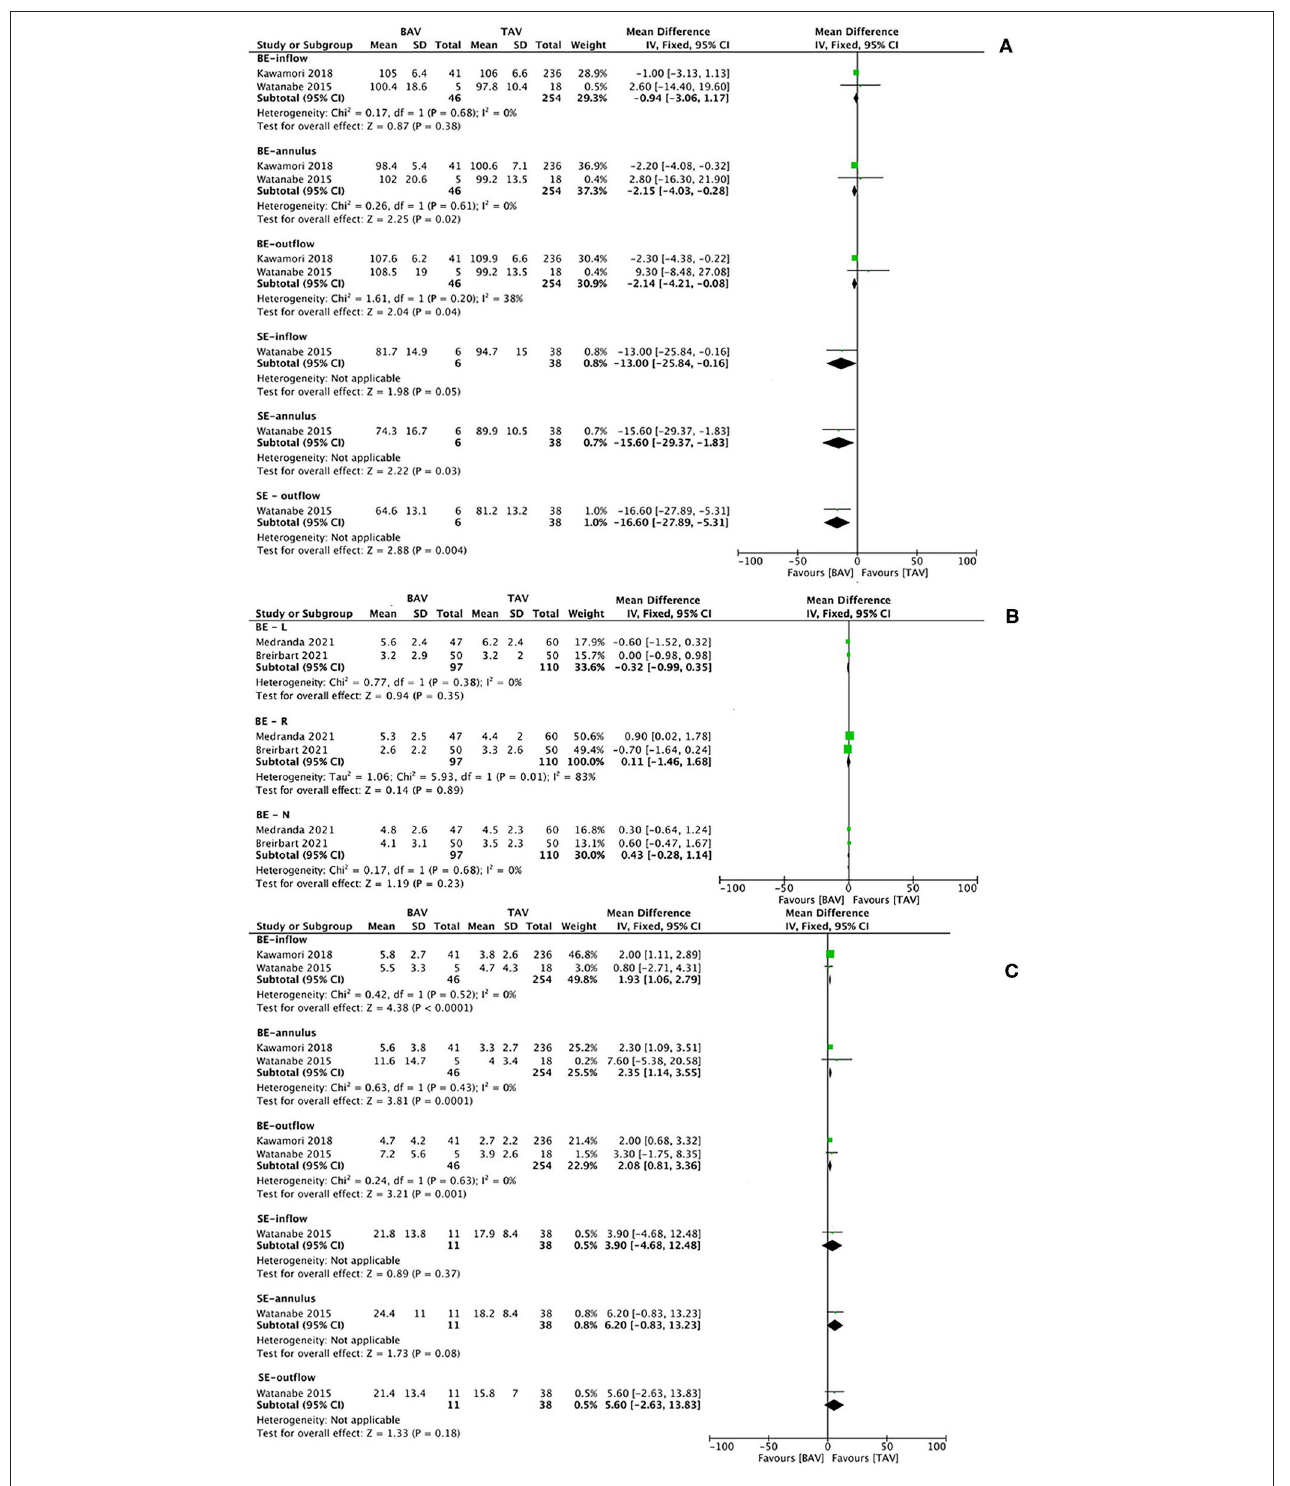
FIGURE 6 | Transcatheter heart valve (THV) expansion (A) , implantation depth (B) , and eccentricity index (C) on CT at different levels after TAVI in patients with BAV vs. TAV. CT image analysis of THVs, dividing into balloon-expandable and SE valves, in terms of the expansion at the inflow, annulus, and outflow level (A) ; implantation depth below left, right and none coronary sinus (B) , and the eccentricity index at the inflow, annulus, and outflow level (C) . BE, balloon-expandable; SE, self-expanding; BE-L, balloon-expandable valve—left coronary sinus; BE-R, balloon-expandable valve—right coronary sinus; BE-N, balloon-expandable valve—non-coronary